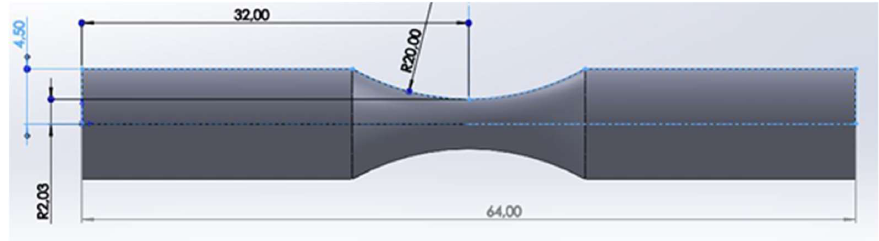
Figure 3. Specimen dimension for fatigue tests.